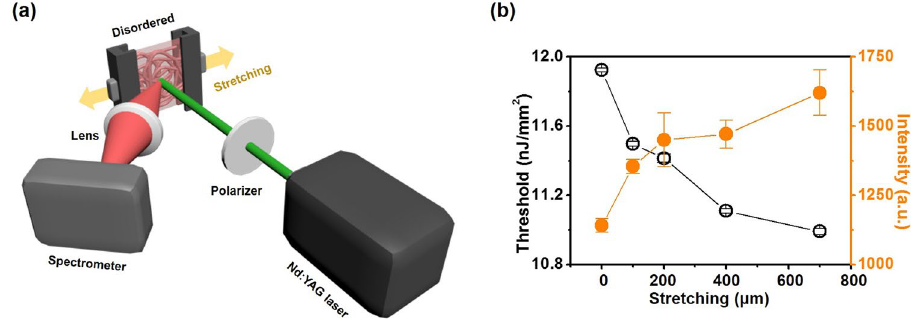
Figure 5. ( a ) PL measurement setup combined with tensile setup ( b ) Measured thresholds and output emission intensities at various tensile loads. The output emission was measured at a pump energy of 12 nJ/mm 2